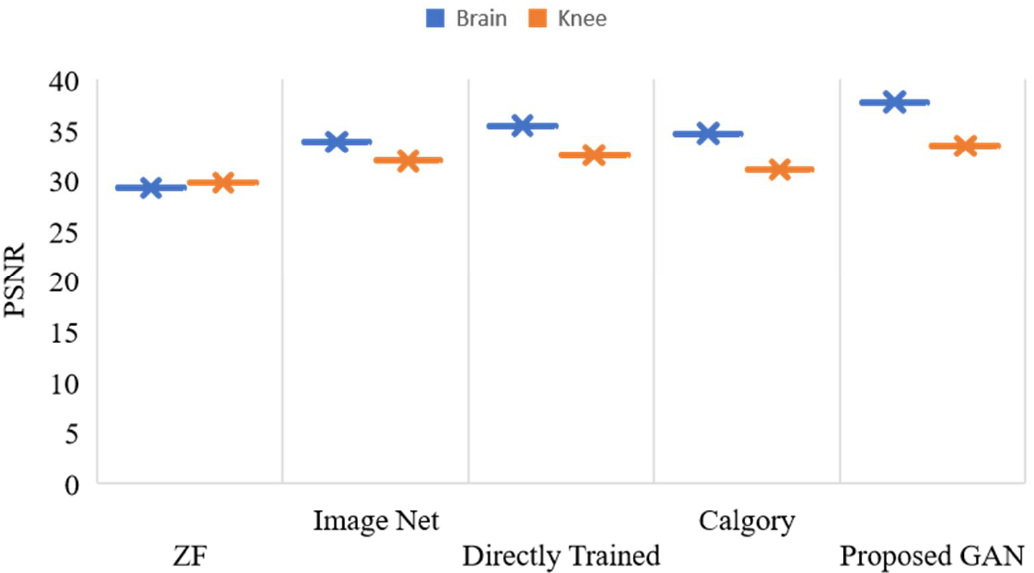
Figure 13. PSNR, values of reconstructed images of the knee and brain using various models, with AF = 4.